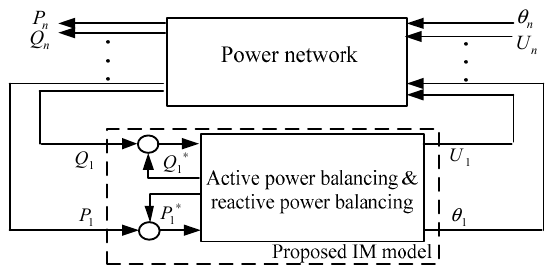
Figure 13. Schematic diagram of a multi-machine system containing the proposed model.